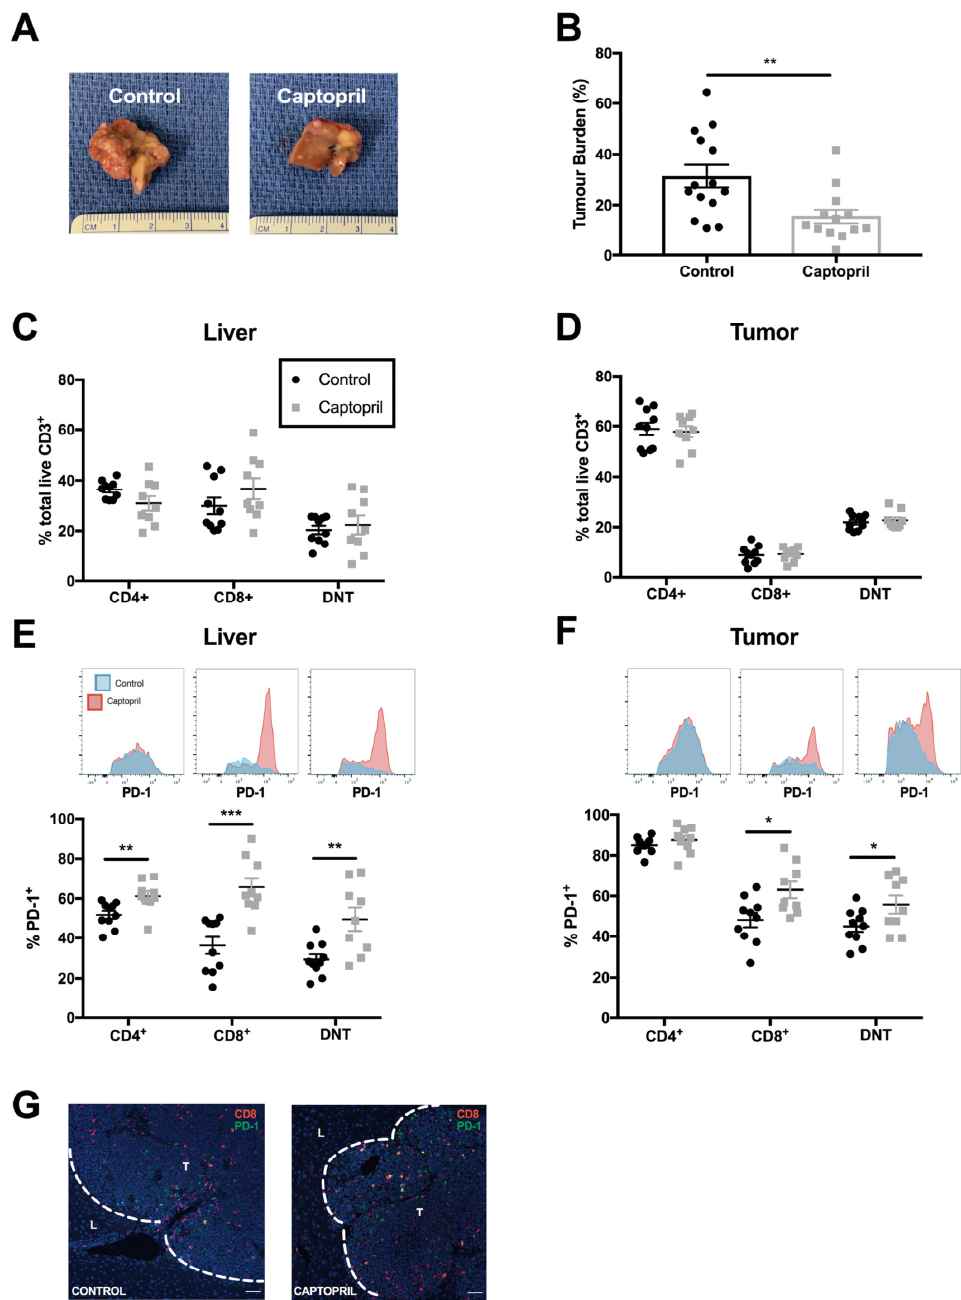
Figure 1. Captopril reduces tumour burden in regenerating liver and alters T-cell composition within liver and tumour tissues. Mice underwent surgical induction of colorectal liver metastasis via splenic injection, followed by splenectomy (Day 0). From Day 4 to Day 16, intraperitoneal injections of captopril 250 mg/kg/day or control (saline) were administered. On Day 7, mice underwent a 70% partial hepatectomy. Mice were culled on Day 16, and liver and tumour samples were retrieved for analysis: ( A ) representative photographs of liver and tumour appearance in the control and captopril treatment groups showed significantly greater tumour burden in the control group, compared with treatment; ( B ) tumour burden in the regenerating liver following partial hepatec- tomy in control and captopril-treated mice. Tumour burden = (tumour volume/total liver volume)